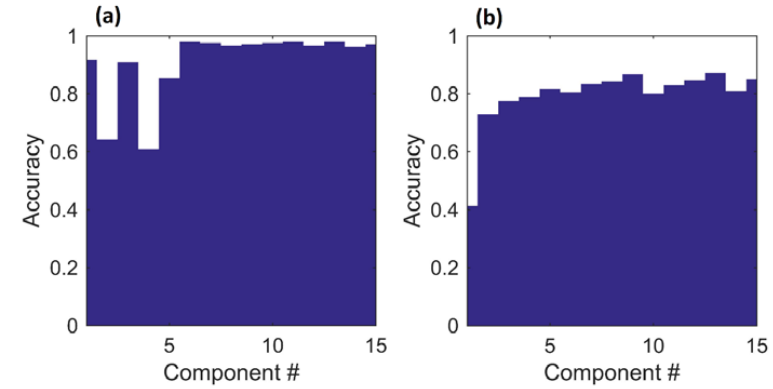
Figure 10. Results of preliminary amplitude feature classification trials using whole amplitude features and SVM classifiers. ( a ) two-class task; ( b ) twelve-class task.